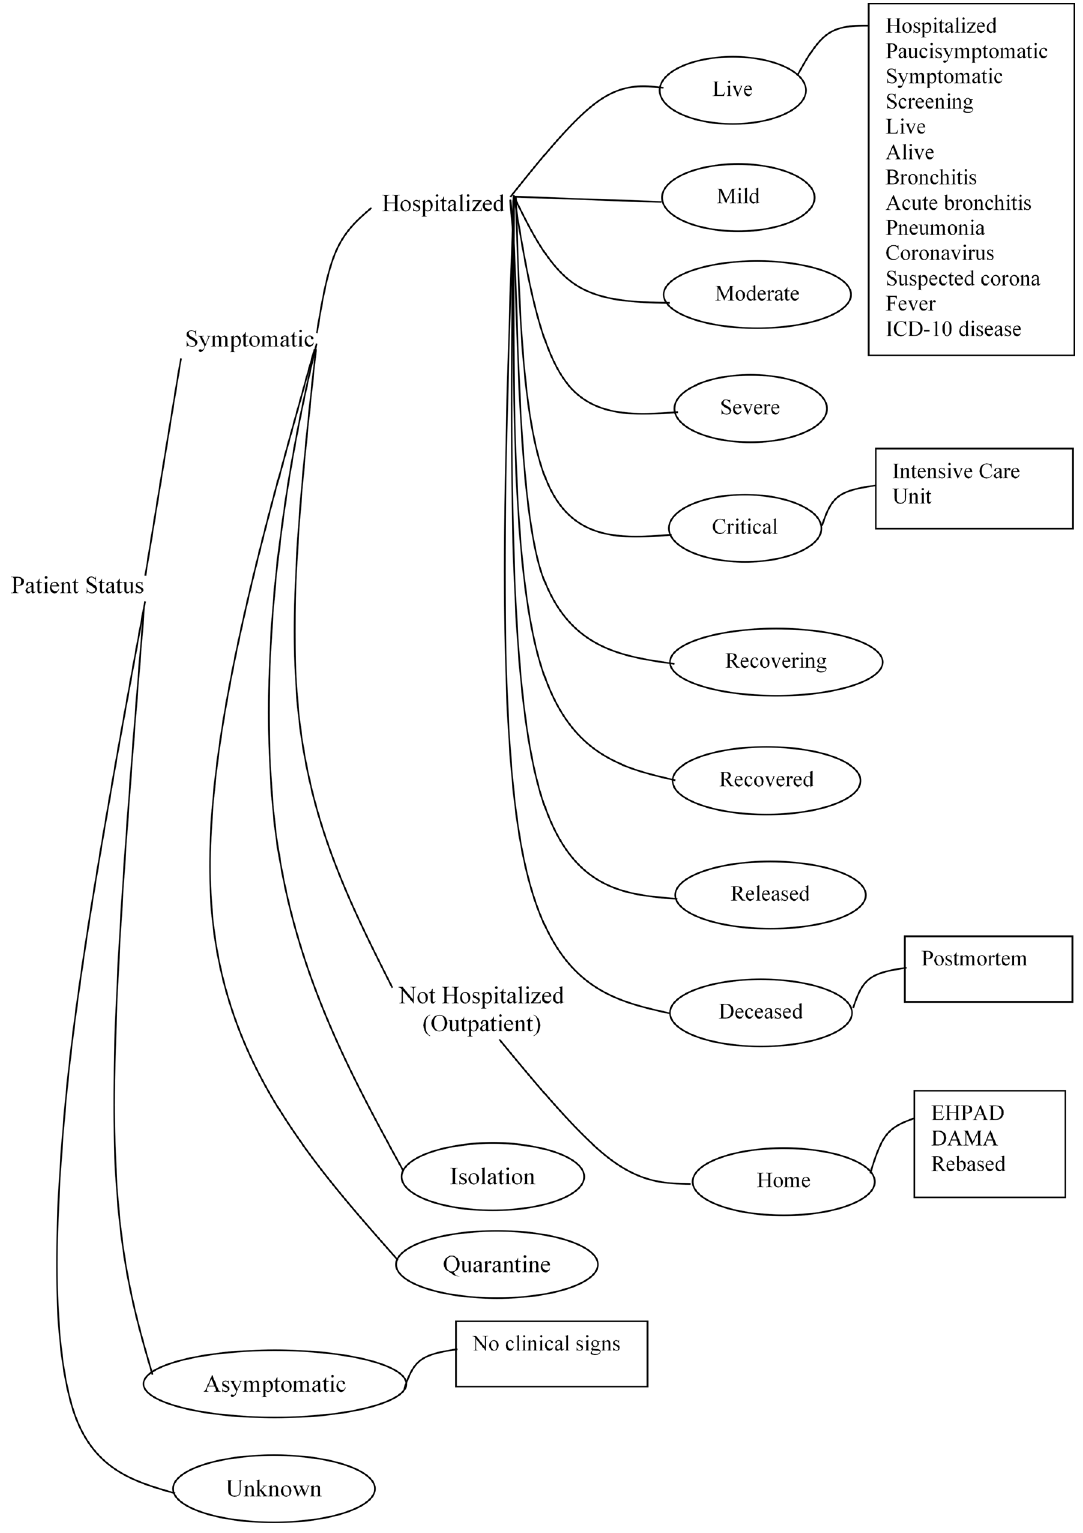
Figure 11. Reclassified GISAID COVID-19 patient status